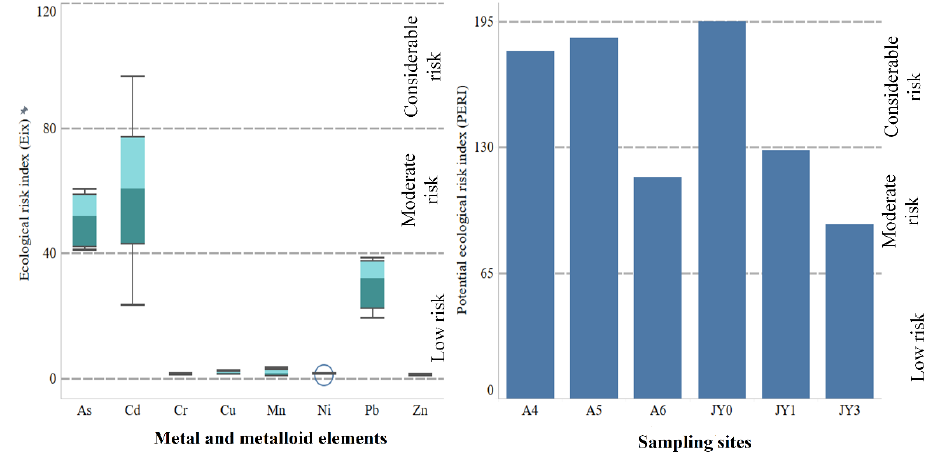
Figure 8. Ecological risk index ( Eix ) and potential ecological risk index ( PERI ) of selective heavy metal and metalloid elements at different sampling sites.